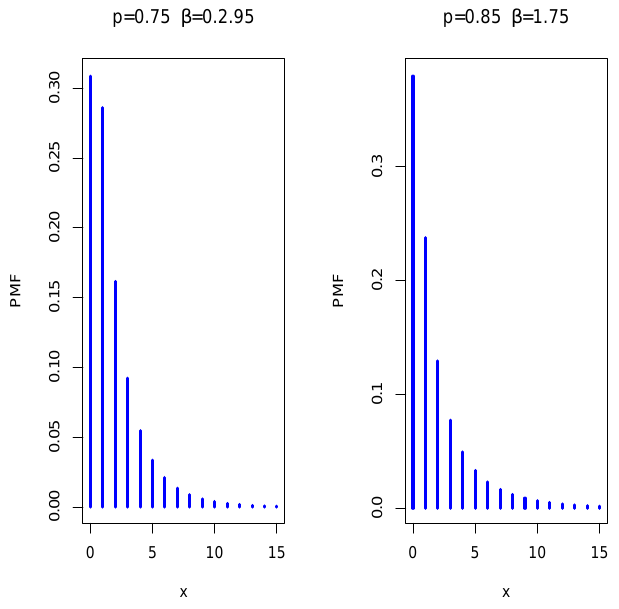
Figure 4. The PMF plots of the DEBuH